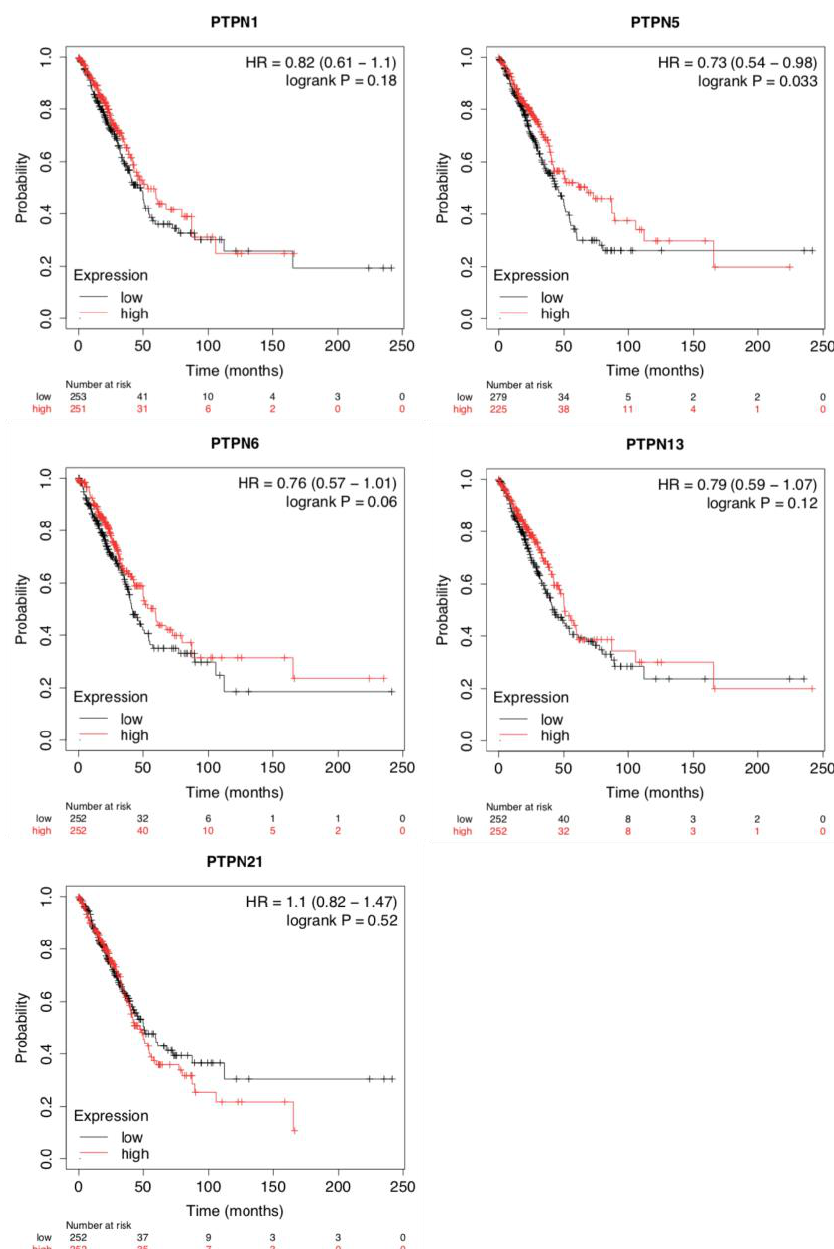
Figure 3. Prognostic values of different expressed protein tyrosine phosphatase non-receptor type (PTPN ) family members in overall survival of lung adenocarcinoma (LUAD) patients (Kaplan–Meier plotter).